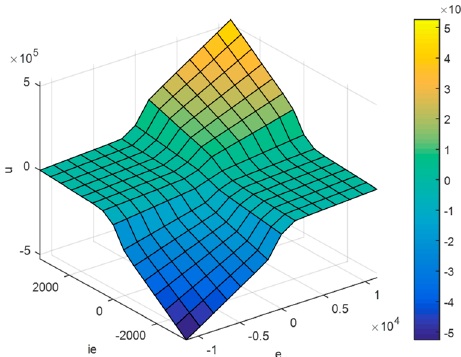
Appl. Sci. 2019 , 9, x FOR PEER REVIEW Figure 20. Membership functions for fuzzy variables: ( a ) e ( t ) ; ( b ) Figure 20. Membership functions for fuzzy variables: ( a )